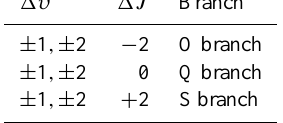
Table 1. Branches of the rotational–vibrational Raman spectrum. (cid:49)υ